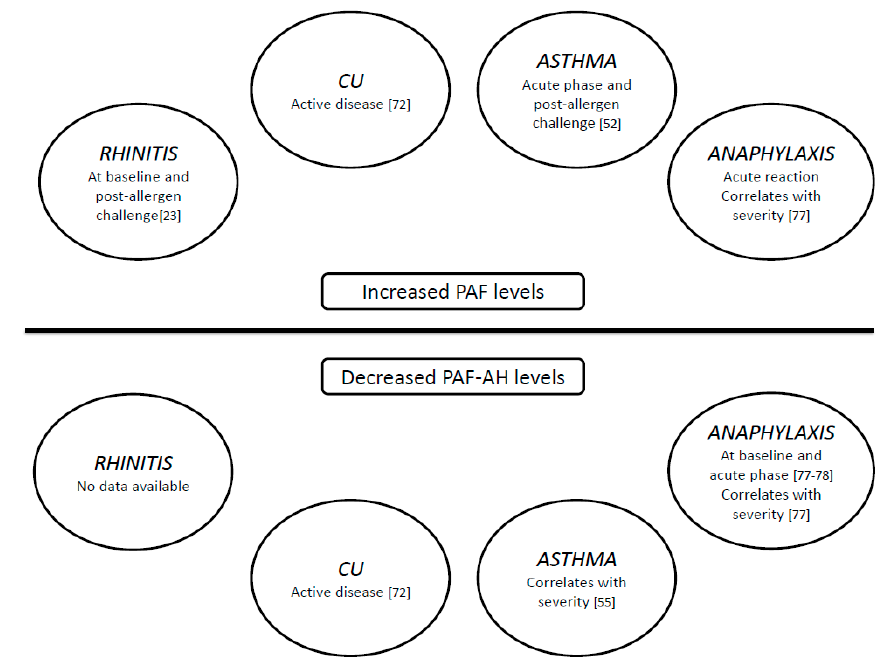
Figure 3. PAF and PAF-AH levels in respiratory diseases, anaphylaxis and chronic urticaria.